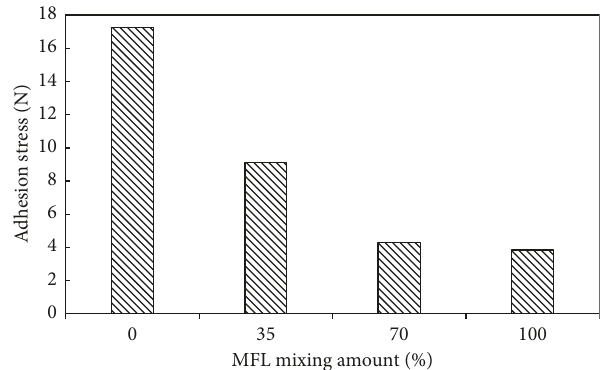
Figure 16: Adhesion variation with MFL mixing